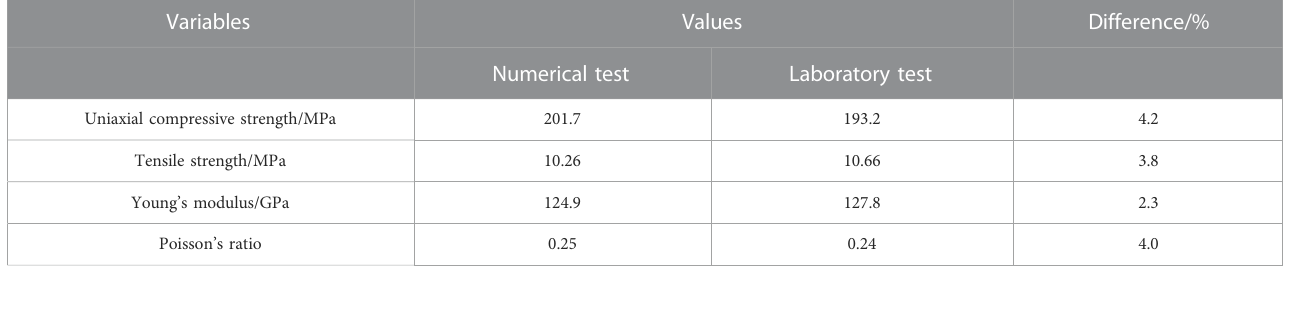
TABLE 2 Macroscopic parameters of rocks. Variables